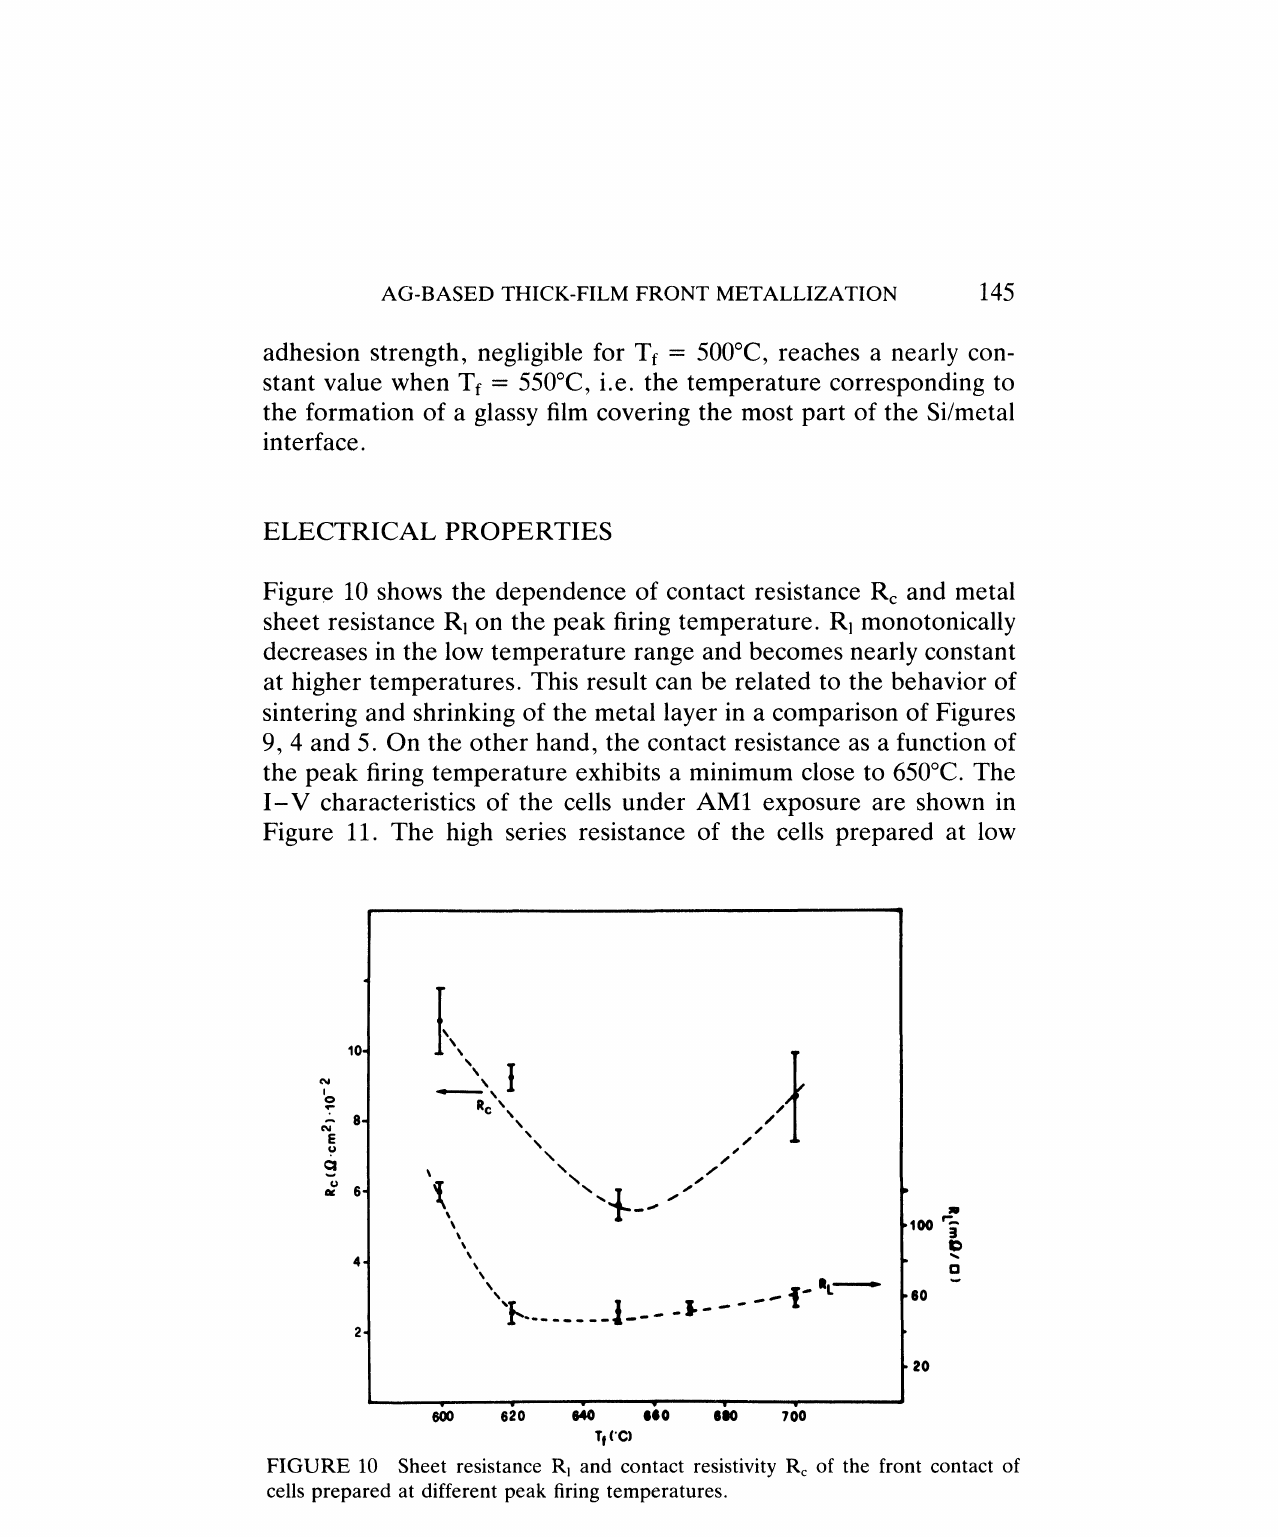
FIGURE 10 Sheet resistance RI and contact resistivity Rc of the front contact of cells prepared at different peak firing